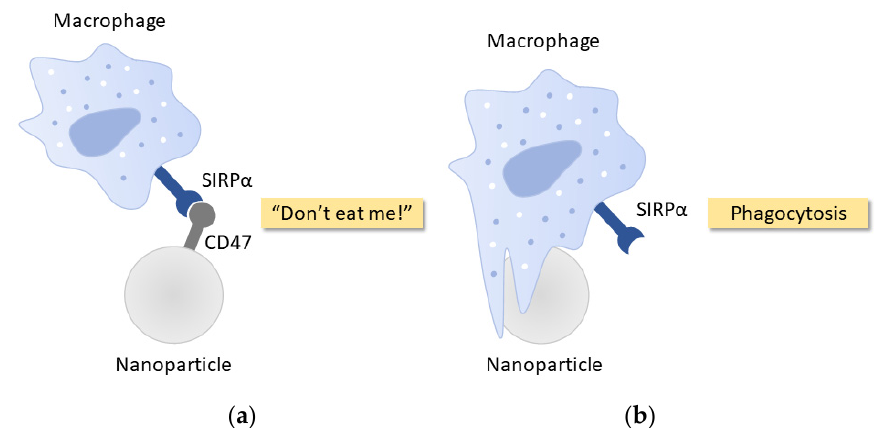
Figure 3. Schematic representations of CD47 regulation on phagocytosis of nanoparticles (NPs). ( a ) CD47 coated on a nanoparticle interacts with the signal regulatory protein alpha (SIRP α ) expressed on the surface of the macrophage, triggering a potent “don’t-eat-me” signal, which inhibits phagocytosis; ( b ) A nanoparticle without CD47 functionalization is recognized by macrophage for particle engulfment and phagocytosis.